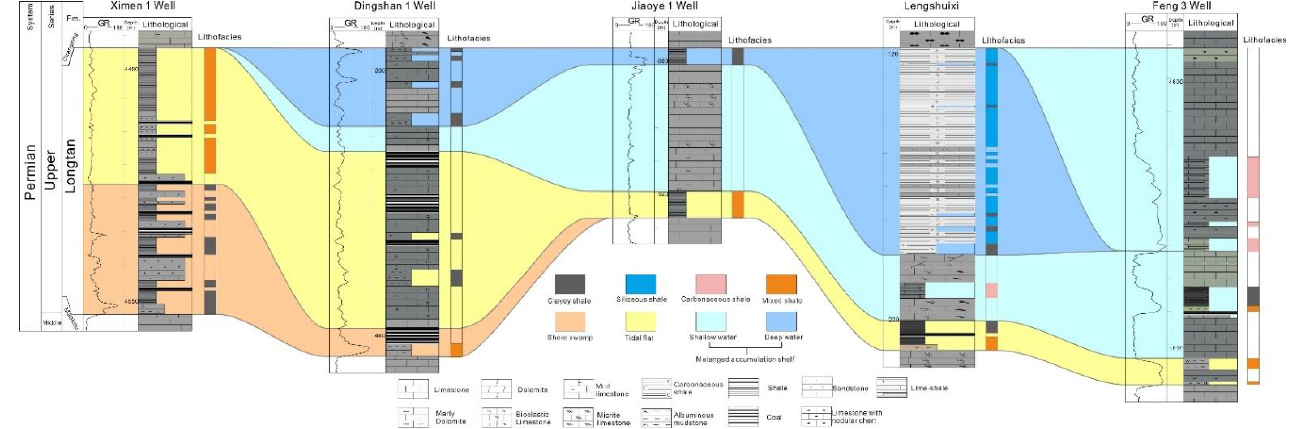
Figure 8. SW–NE cross-section through different wells in the study area.